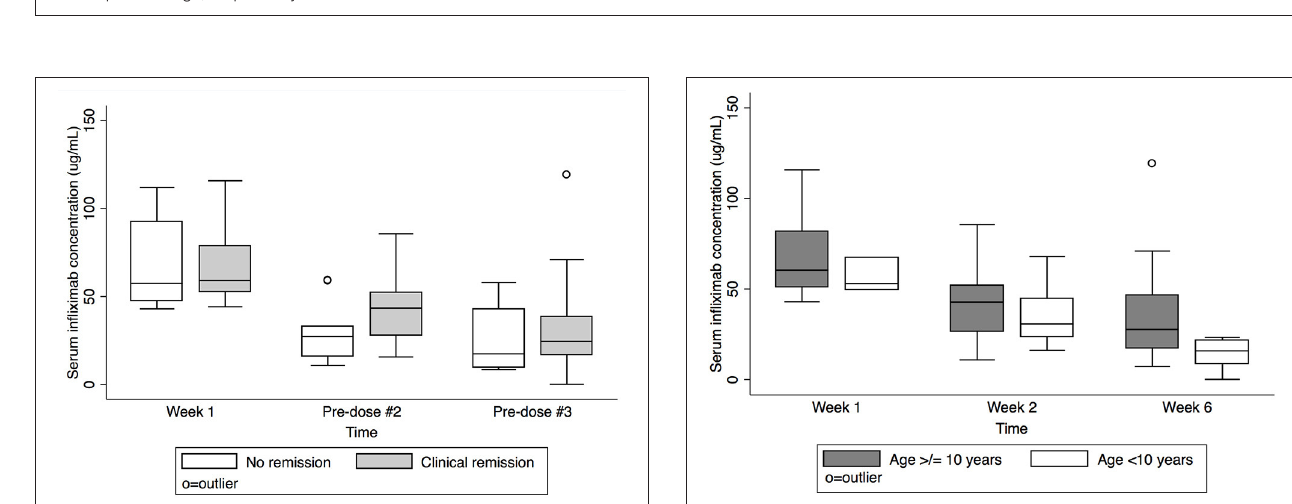
concentration ≥ 29 µ g/ml was the optimal cut-point to target pre-dose #3 ≥ 18 µ g/ml (AUROC 0.82, 95% CI 0.70–0.94).